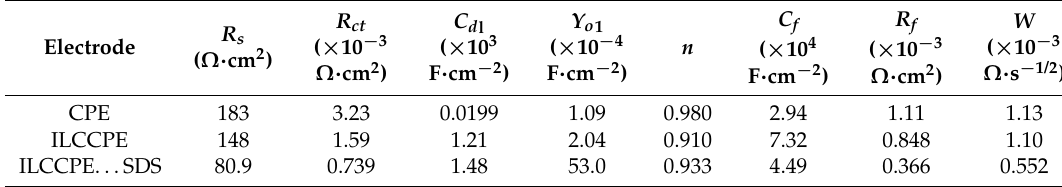
Table 2. Electrochemical impedance spectroscopy fitting data corresponding to Figure 3.